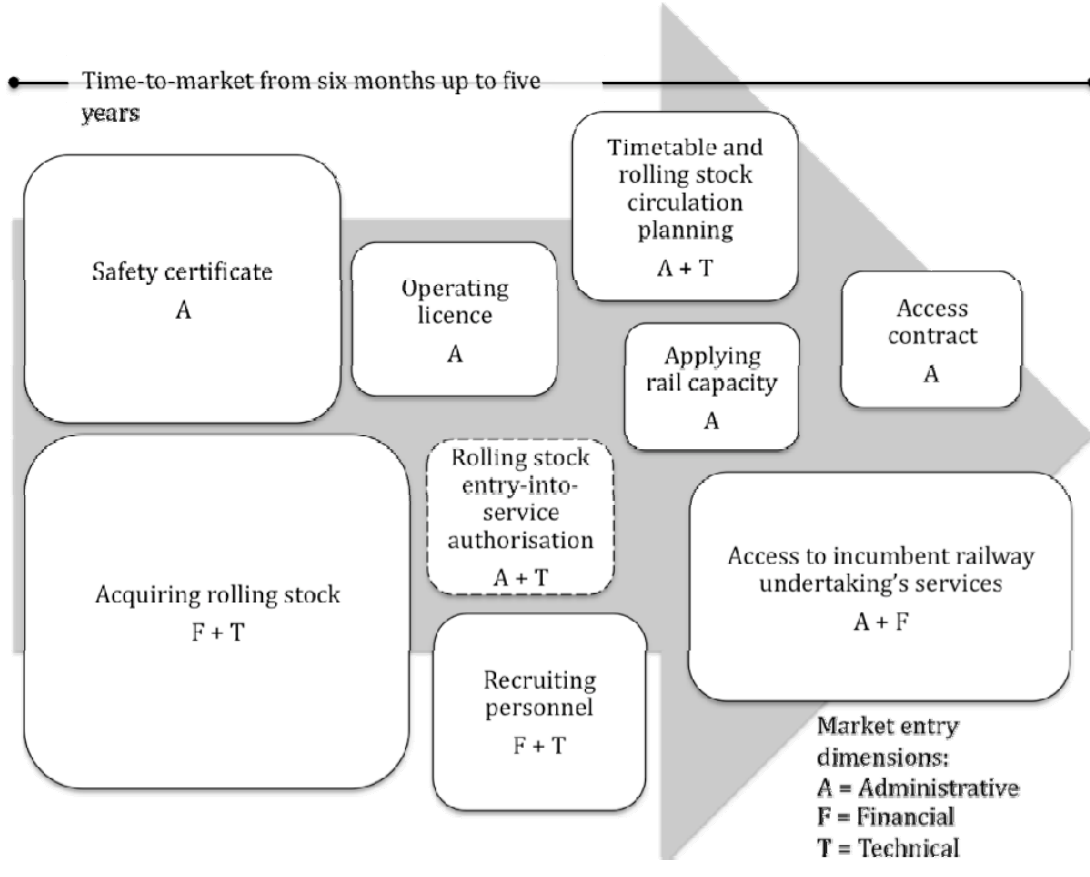
Figure 3. Market entry phases and entry barriers in rail freight transport (Source: Mäkitalo,